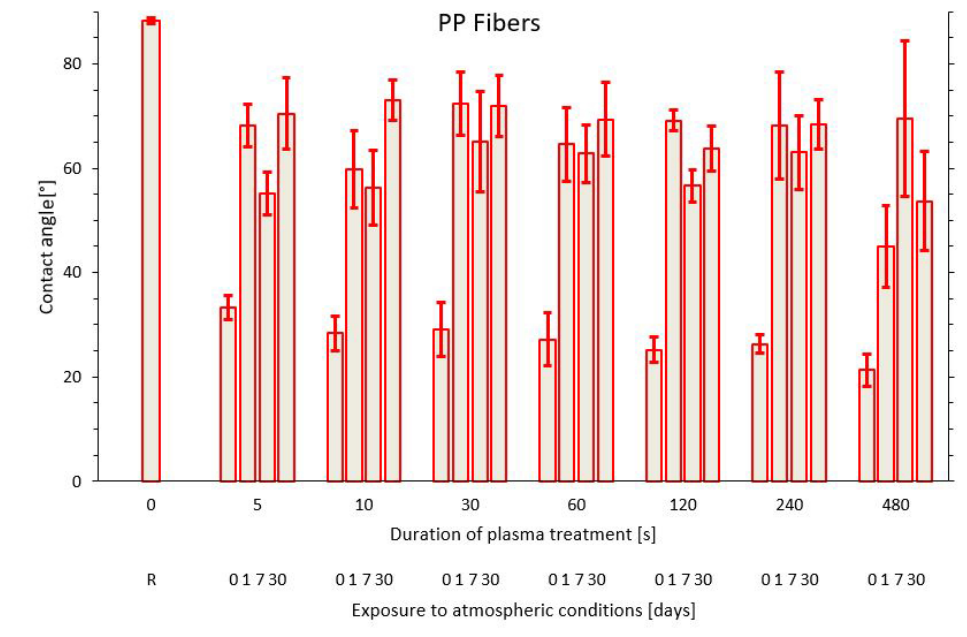
Figure 3. PP fibers – dependence between contact angle, duration of plasma treatment and time of exposure to atmospheric